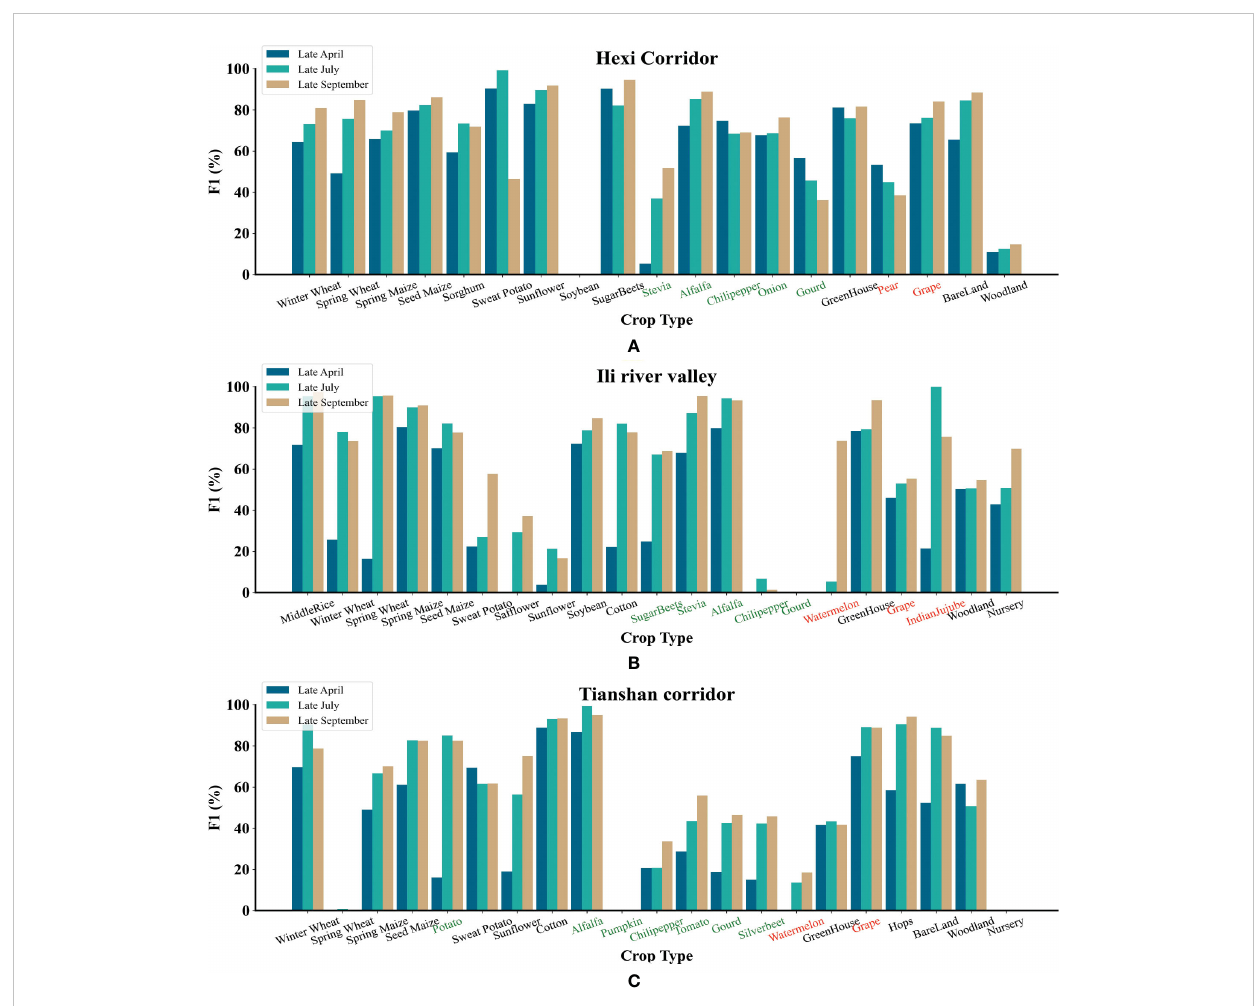
FIGURE 9 F1 scores for each crop type in the three study areas using Cropformer at the end of April, July and September. Where the green axis headings indicate vegetables and the red axis headings indicate fruits. (A) Hexi Corridor F1 Score (B) Ili River Valley F1 Score (C) Tianshan Corridor F1